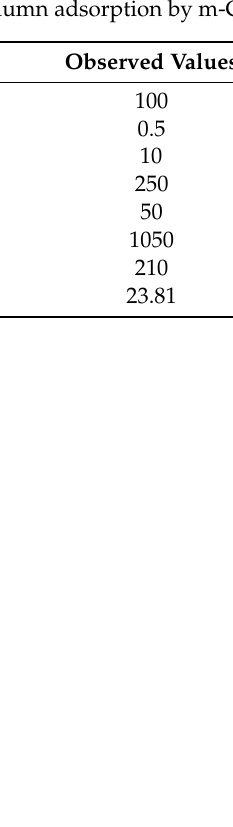
Figure 11. RO 16 dye Column adsorption curve for m-CGPA.